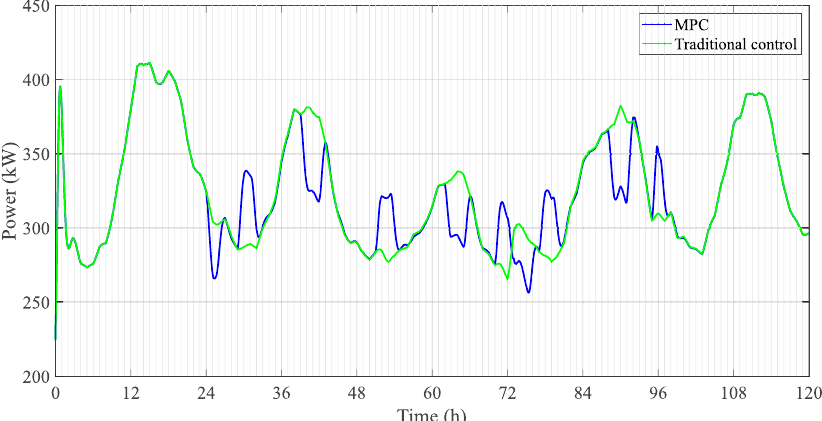
Figure 8. Compression power of the single-objective case study with the MPC and the traditional control strategies. Table 4. KPI values for the single-objective case study. (n/a = not applicable). Control